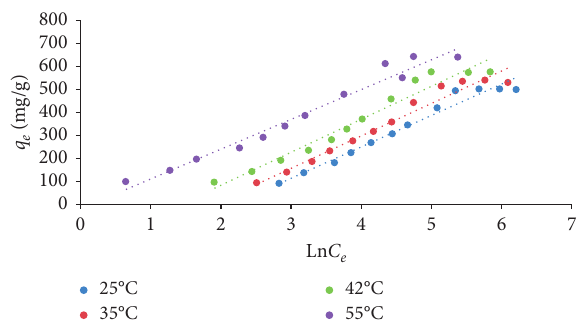
− ions sorption by ZCOBLP. 4